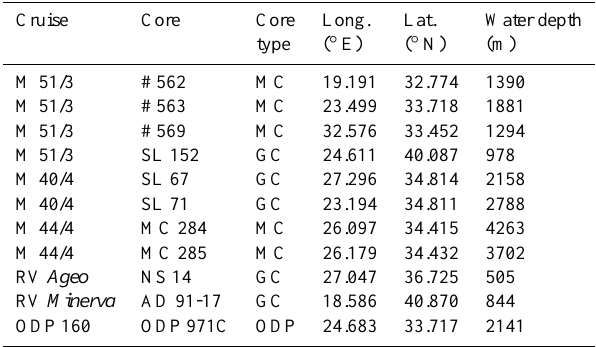
Sediment sampling locations and sample types: MC = Multicore, GC = Gravity Core, ODP = Ocean Drilling Pro- gram